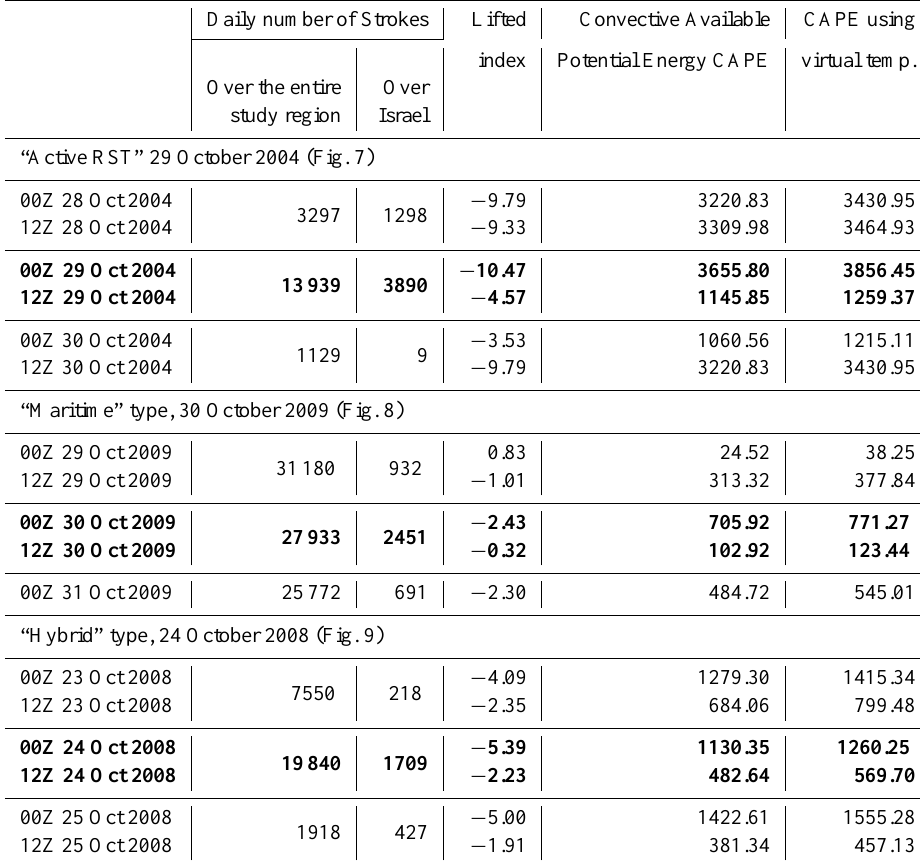
Table 2. Instability indices for the 3 case studies, including the day prior to and after their occurrence. Daily number of Strokes Lifted Convective Available CAPE using index Potential Energy CAPE virtual temp. Over the entire Over study region